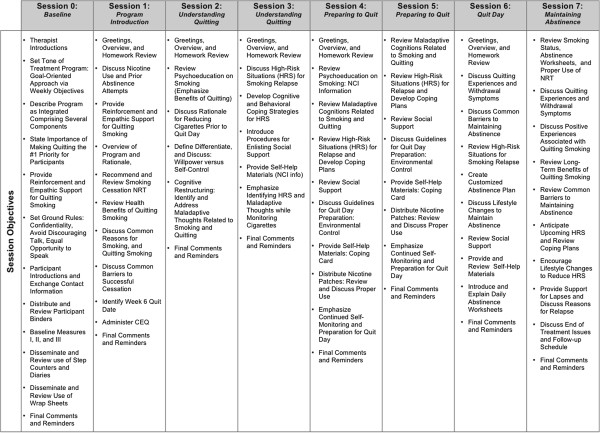
Overview of session objectives.